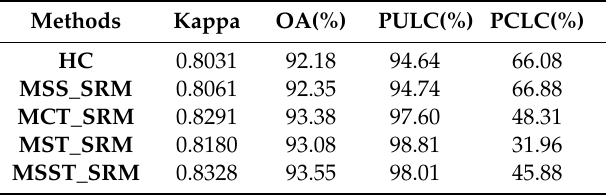
Table 4. Accuracy statistics of the di ff erent methods for Daye